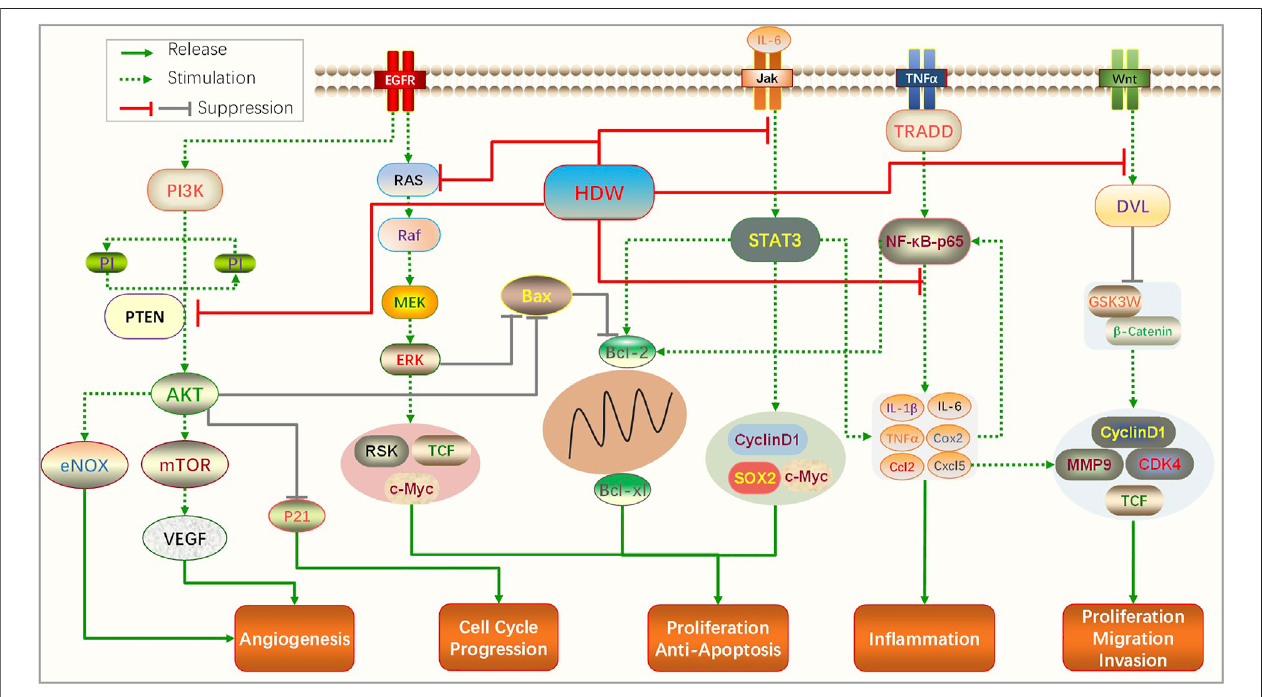
FIGURE 1 | Main signaling pathways and molecules of HDW act on